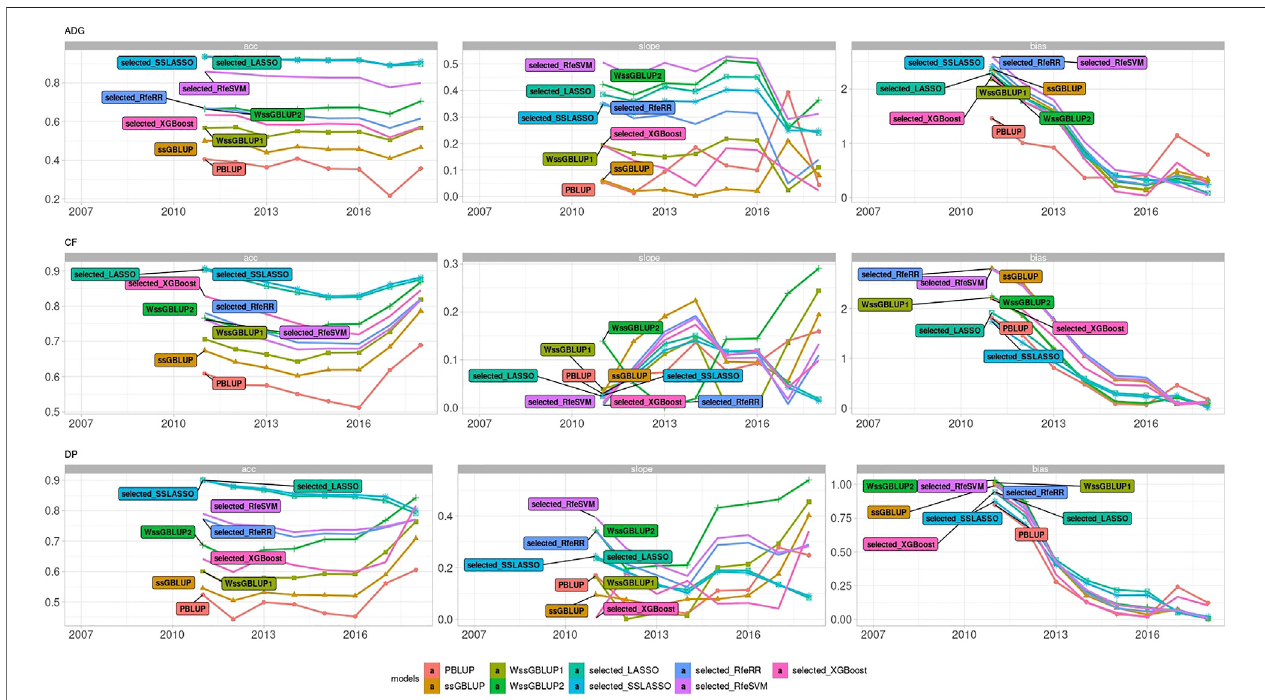
FIGURE 9 | Line plot representing accuracy, dispersion, and bias of Rendena data set estimated using LR cross-validation in the validation cohort of 2021. Dispersion was represented as 1, absolute value of dispersion, while bias as absolute values of bias divided by its genetic variance.